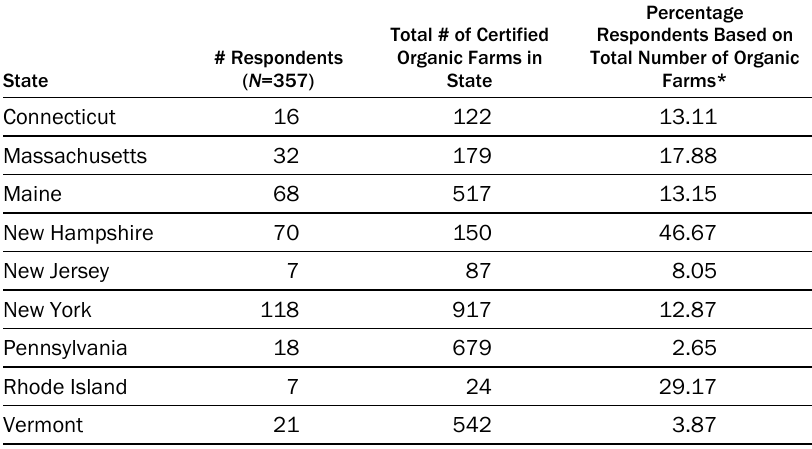
Table 1. Comparison of Number of NOFA Farmer-Members Responding to Survey and Number of Certified and Exempt Organic Farms in Each State